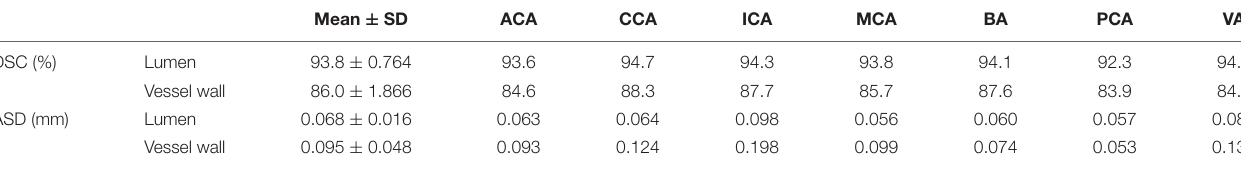
TABLE 2 | The DSC and ASD for the lumen and the vessel wall when comparing automatic and manual method on the nine-subject test set.